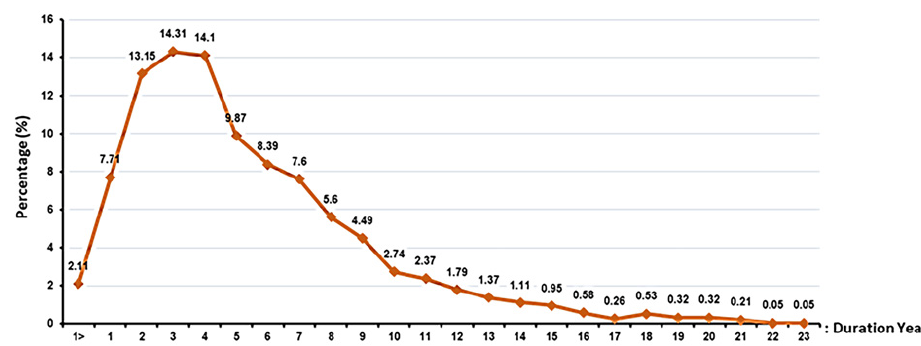
Figure 6. The duration of each clinical trial study using stem cells.